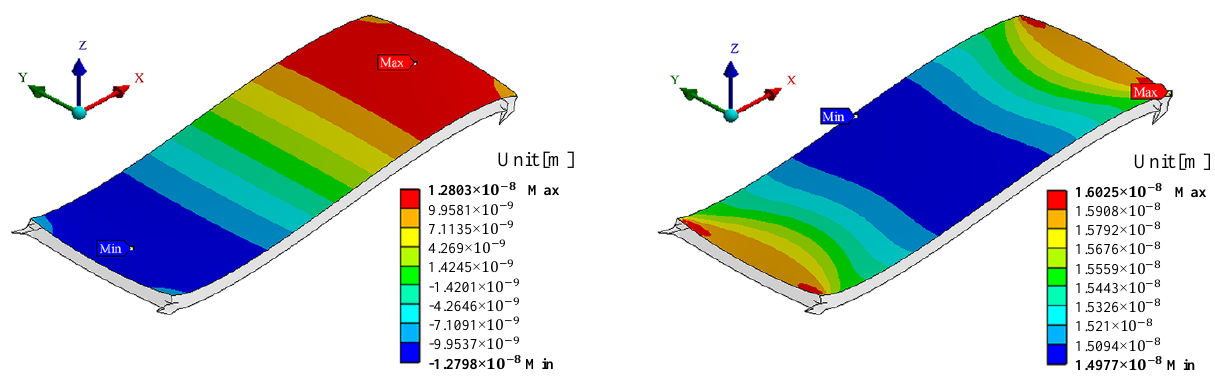
Figure 8. Vibrational displacement on the surface of the touch screen according to the vibration direction of the